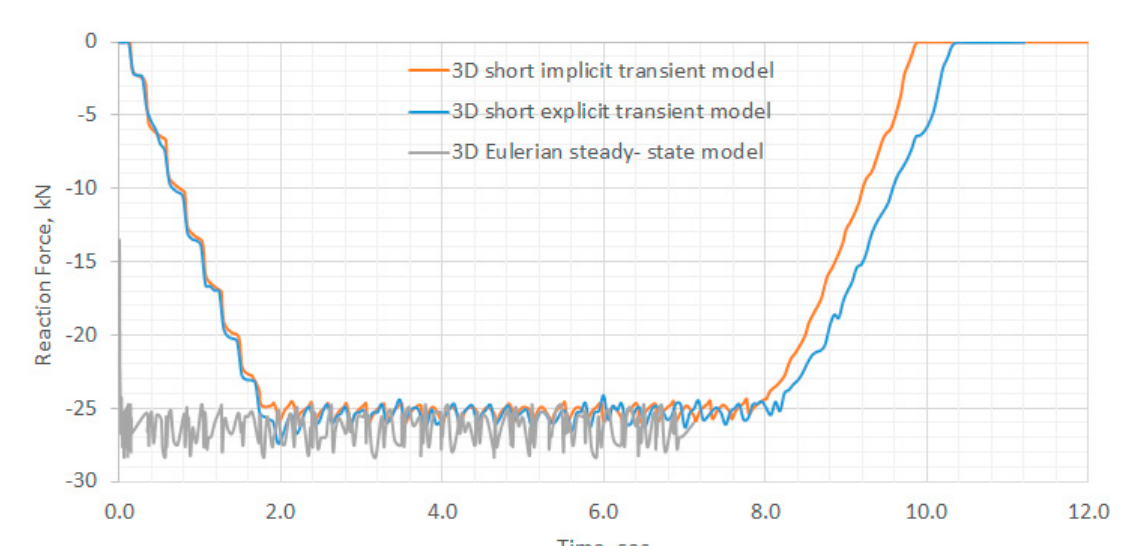
Figure 6. Reaction forces obtained at the rotation point of the rollers (note that only half of the WAAM component was considered in the models).